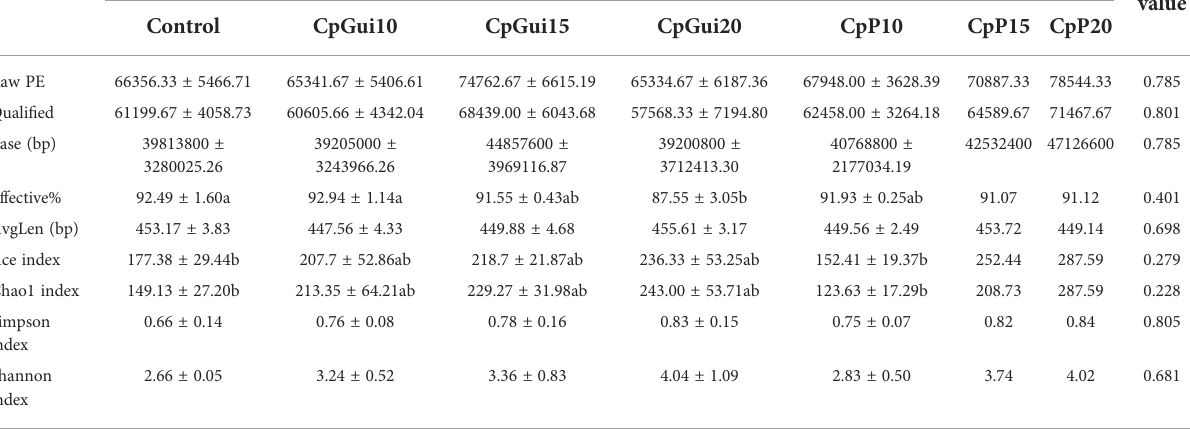
TABLE 5 Diversity and richness of bacterial sequences in the ileum of pigs fed on the various diets.